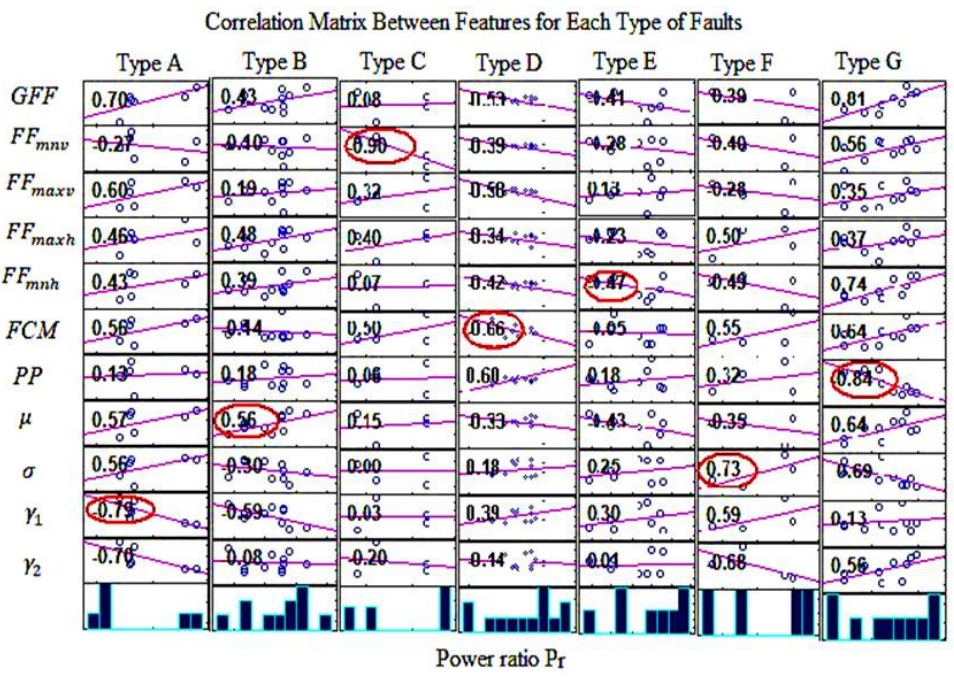
Figure 5. Correlation matrix between features and operating power ratio for each type of fault.